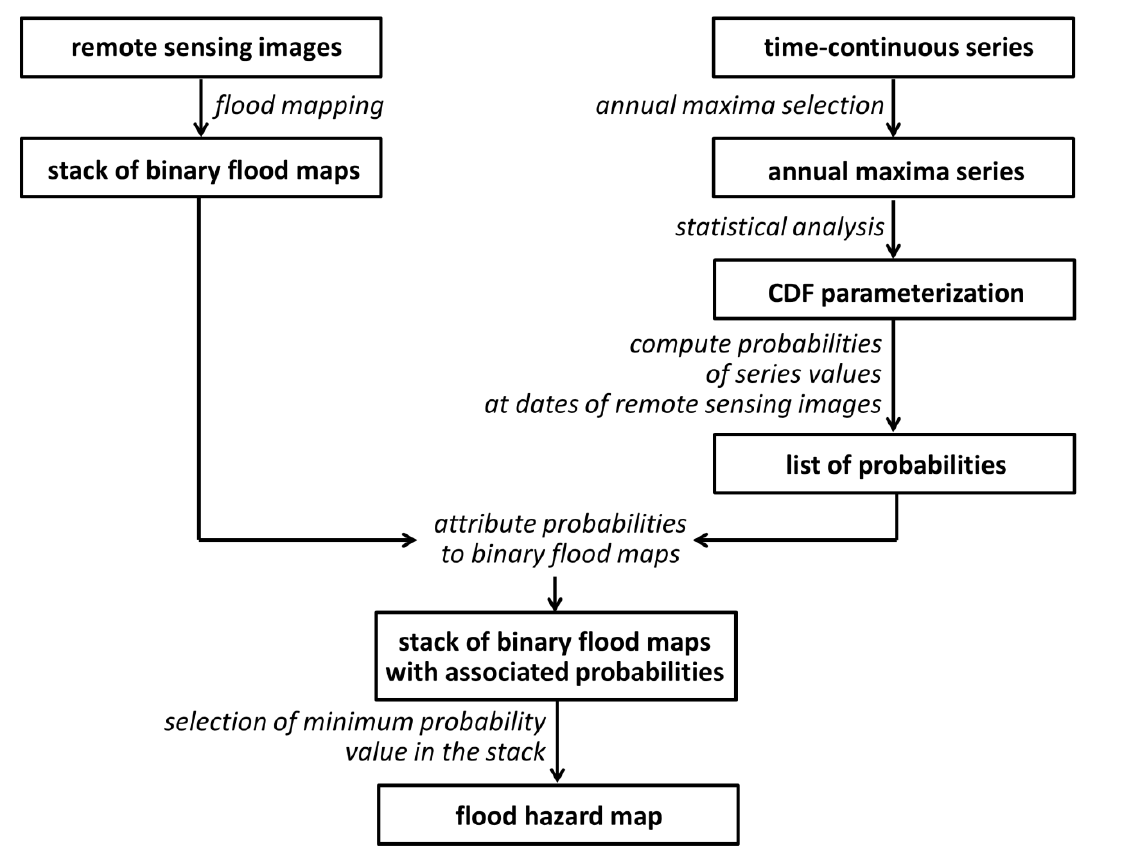
Figure 1. Flowchart of the